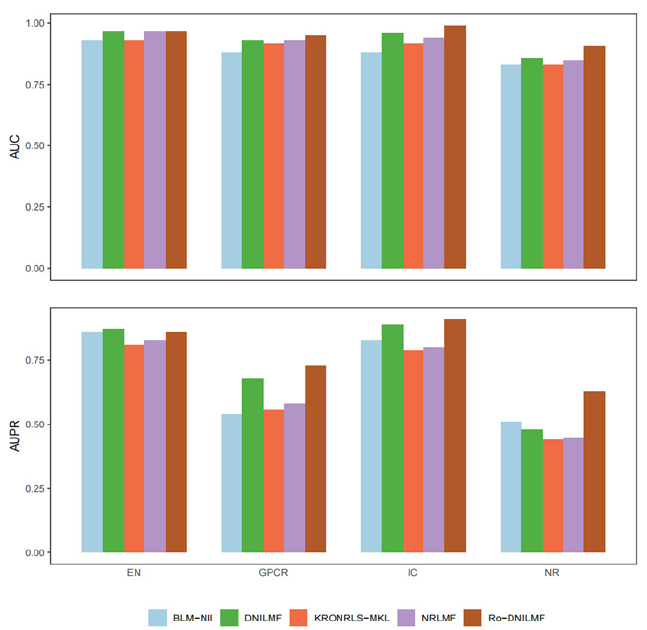
Figure 5. Comparative results of the presented method and other mainstream methods.